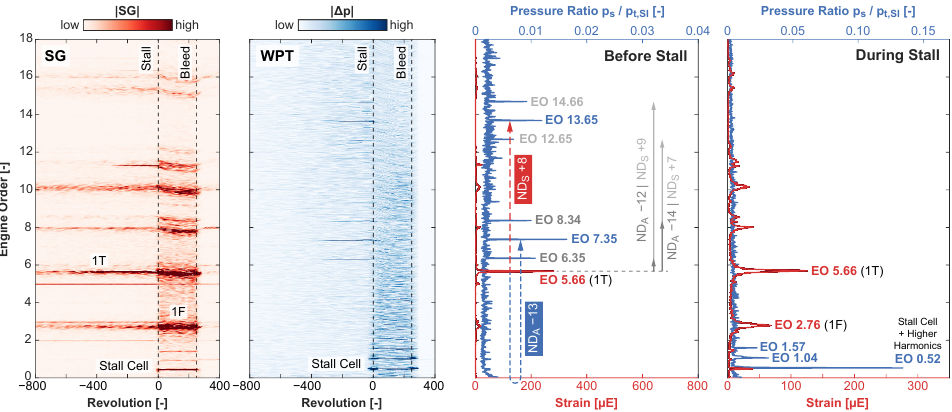
Figure 9. SG and WPT spectra of the throttling maneuver at DS for the OLC configuration. Because the measured SG strain strongly depends on its positioning on the blade and the blade geometry, the strain magnitude is not appropriate for comparing different rotors. Furthermore, the different SG sensitivities of different modes are crucial. To gain a better understanding of the temporal progression of the 1T vibrations that occurred and their maximum amplitudes, Figure 10 illustrates the bandpass-filtered SG signal for the 1T mode and the bandpass-filtered WPT signal for the corresponding aerodynamic traveling wave. The SG amplitudes are referred to their maximum strain—given as a percentage of the operating limit—to indicate safe operation. In addition, the time of stall inception is marked, as well as the time when the SG amplitudes reached 10% of the operating limit. In order to visualize the temporal progression of the pressure rise of the rotor during the throttling maneuver, the total-to-static pressure rise coefficient Ψ t − s , as defined by Jüngst [9], was used. Ψ t − s is referred to its maximum value at PE for the OLC configuration and depicted in the subfigure below. WPT Peak at EO7.12 SG 1T (VSV nominal) StallSG Amplitudes Bleed reach 10 % of operating limit